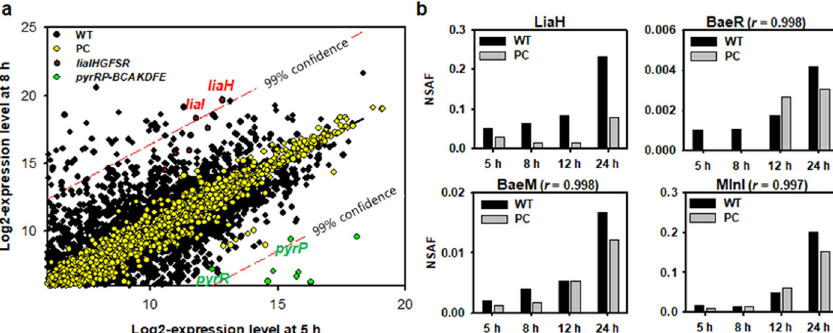
Fig. 9 Differential gene expression in the exponential phase of Bacillus velezensis strain GH1-13. a Plots of log 2 normalized RNA-Seq data for the early (5 h) and late (8 h) exponential phases of wild-type (WT) pBV71 plasmid-containing and plasmid-cured (PC) cells, showing the signi fi cant increase of liaIH transcripts with 99% con fi dence by >6.5log 2 -fold in the late-exponential phase of WT cells, with a signi fi cant decrease of pyr operon transcripts. b Normalized spectral abundance frequency (NSAF) ratios of proteins in whole-cell lysates from the different incubation times of WT and PC cells in Supplementary Data 6, showing signi fi cantly high levels of the pBV71 plasmid-induced LiaH protein compared to that of PC cells (two-tailed Z -test, P < 10 ‒ 6 ) with strong correlation to the levels of polyketide synthases BaeM, BaeR, and MlnI determined by post hoc tests (Pearson ’ s coef fi cient, r > 0.99).